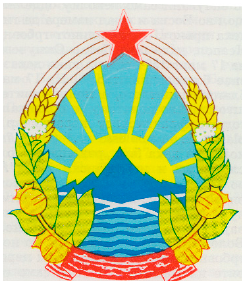
Figure 1. The Soviet style emblem of the Socialist Republic of Macedonia, officially called “Coat of Arms” 15 from 1970 book “The Coats of Arms of Macedonia” by Aleksandar Matkovski. Towards the end of 1991 16 , the political parties represented in the Assembly were in favor of a public competition to select the state symbols, without mentioning any specific symbol. The political Party VMRO-NP 17 , although supporting the public competition, advocated a specific proposal for a coat of arms with a lion ( Чaнговa